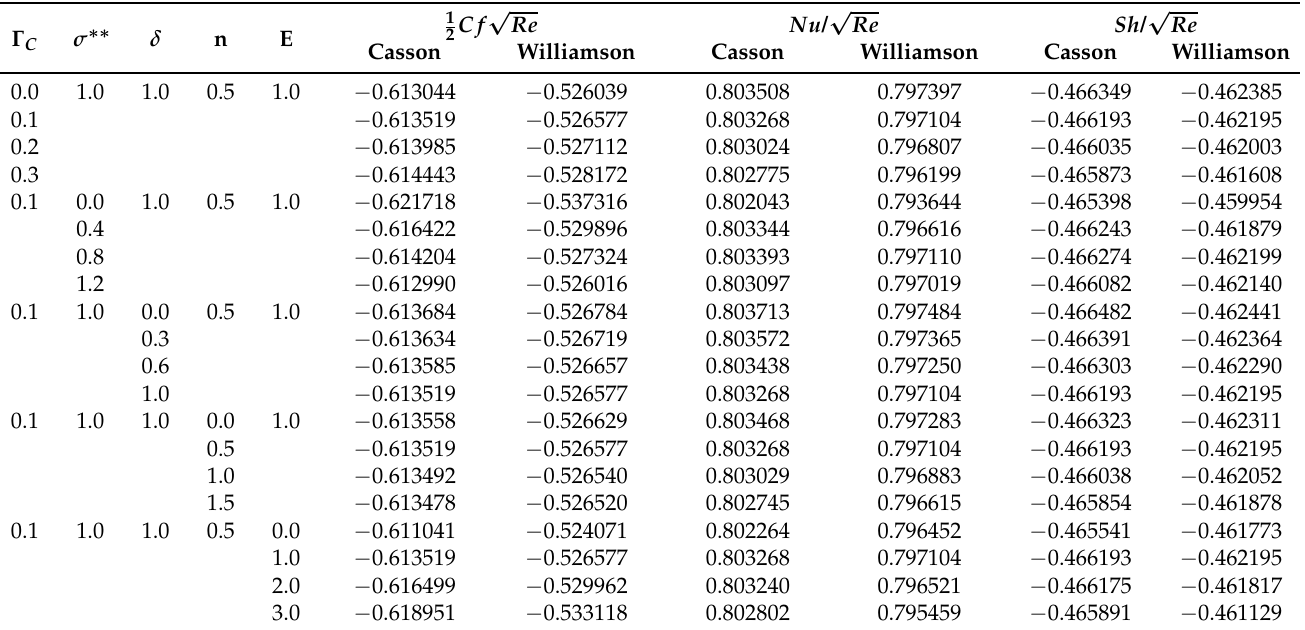
Table 3. The skin friction coefficient, local Nusselt number and local Sherwood number for Γ c , σ ∗∗ , δ , n and E for both fluids.